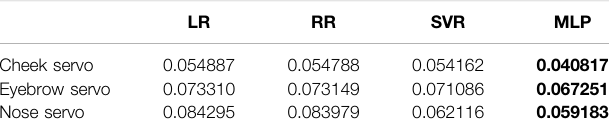
TABLE 2 | RMSE on test set for best models. Lowest values are highlighted in